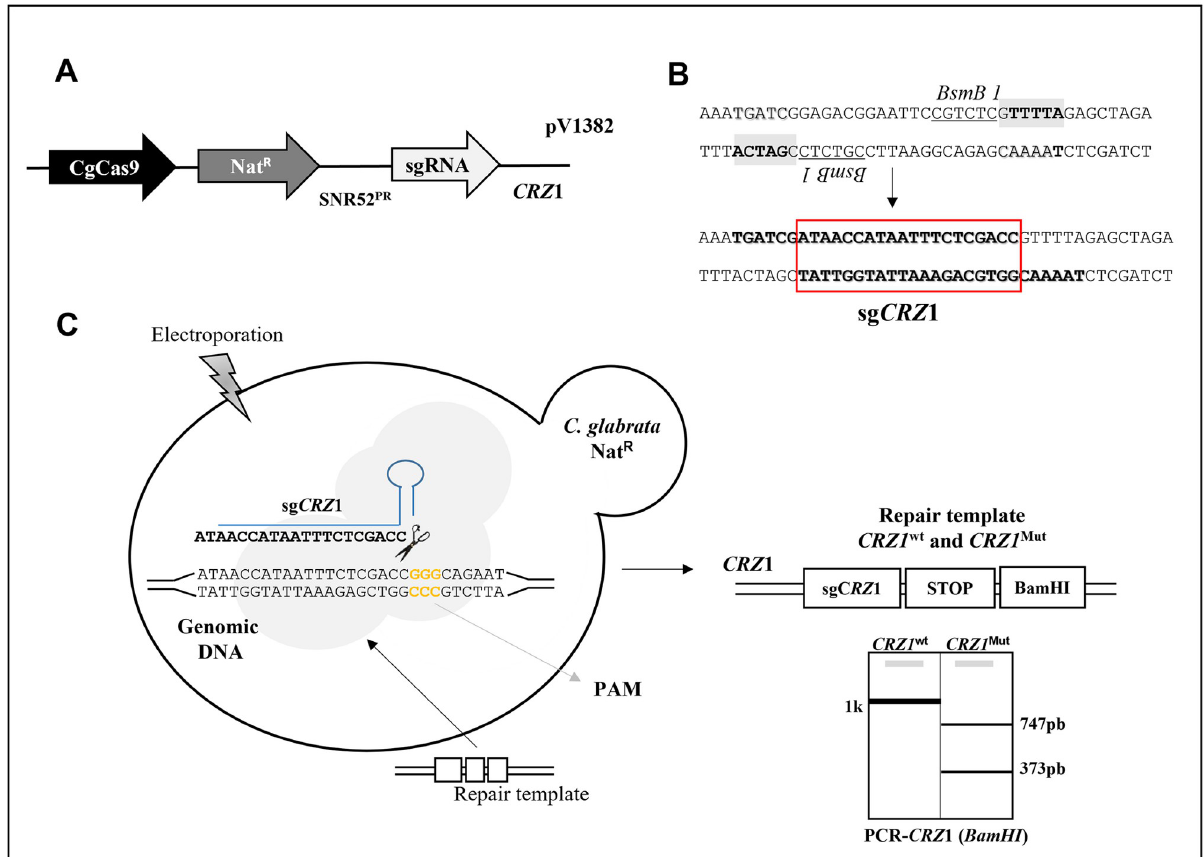
Fig 1. Construction of CRISPR mutants for CgCRZ 1. A . The plasmid pV1382 contains CgCAS9, the nourseothricin resistant gene (Nat R ) and SNR52 promoter that control the expression of the desired sgRNA. B . pV1382 permits a rapid cloning by BsmB I digestion followed by ligation of annealed oligos (boldface type) containing the Cg CRZ1 sequence of synthetic guide RNA (in red bracket). C . Scheme of Cg CRZ1 mutagenesis mediated by CRISPR/Cas9. sg CRZ1 guides the nuclease Cas9 to the specific genomic site and allows DSB next to protospacer adjacent motif (PAM). Homology directed repair (HDR) with a repair template containing two stop codons (TAA-TGA) and one BamH I restriction site allows further analysis of crz1 mutants by PCR.